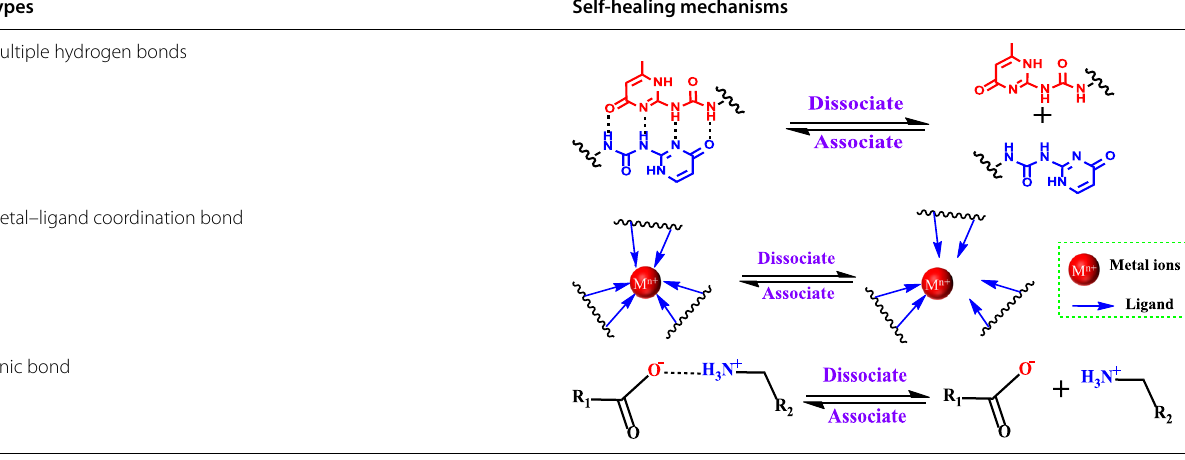
Table 2 Types and self-healing mechanisms of main dynamic noncovalent bonds for room-temperature self-healing polyurethanes